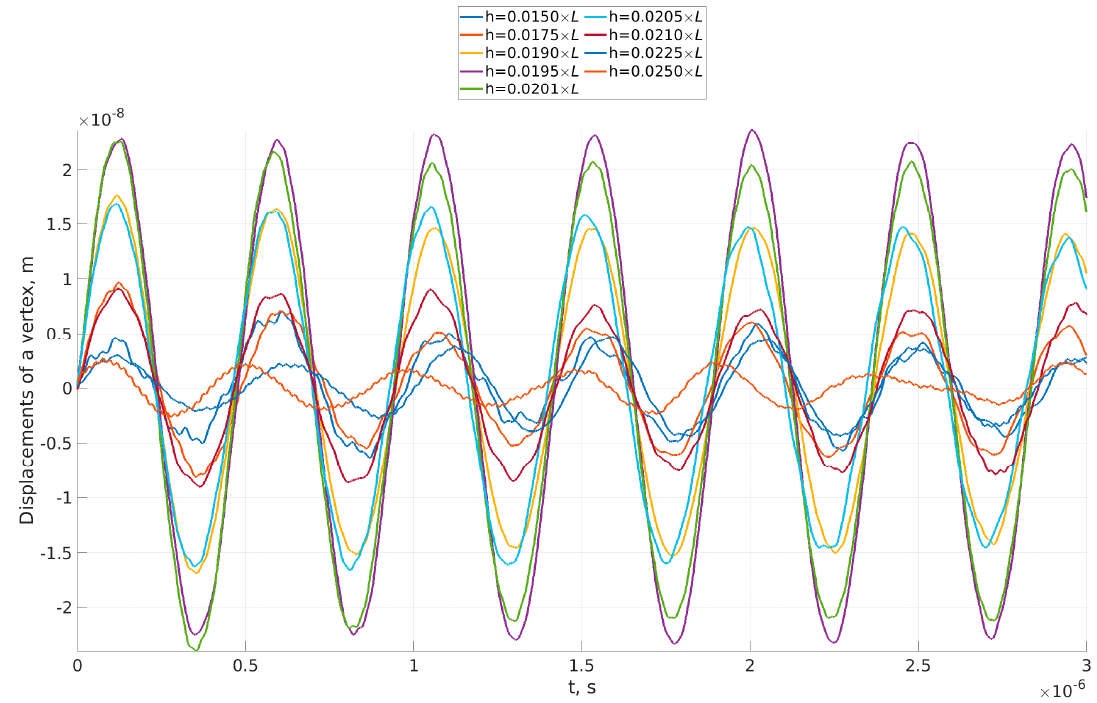
Figure 8. Time–history diagram of deflection of tip of beam for beams with 9 thicknesses.